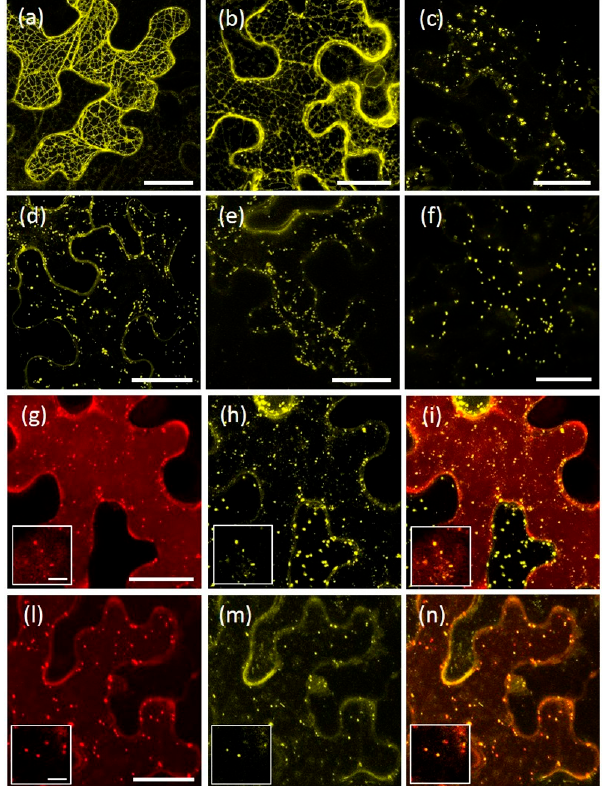
Figure 4. Unchanged localization of AtRMR1 and -2 deletion mutants. Stacked confocal images of epidermal cells expressing the fusion protein: AtRMR1 Δ Ring-YFP ( a ); YFP-AtRMR1 Δ PA ( b ); AtRMR2 Δ Ser-YFP ( c ); AtRMR2 Δ RingSer-YFP ( d ); YFP-AtRMR2 Δ PA ( e ); and YFP-AtRMR2 Δ PASer ( f ). Co-localization of AtRMR2 and its deletion mutants in N. benthamiana leaves ( g – n ): Stacked confocal images, excepted inserts ( g – n ; single images) of epidermal cells expressing AtRMR2-RFP and the deletion mutant AtRMR2 Δ RingSer-YFP ( g – i ); or AtRMR2-RFP and the deletion mutant YFP-AtRMR2 Δ PASer ( l – n ). RFP signal ( g , l ); YFP signal ( a – f,h,m ); and merged images ( i , n ). Scale bars = 30 µm; and 5 µm (inserts).